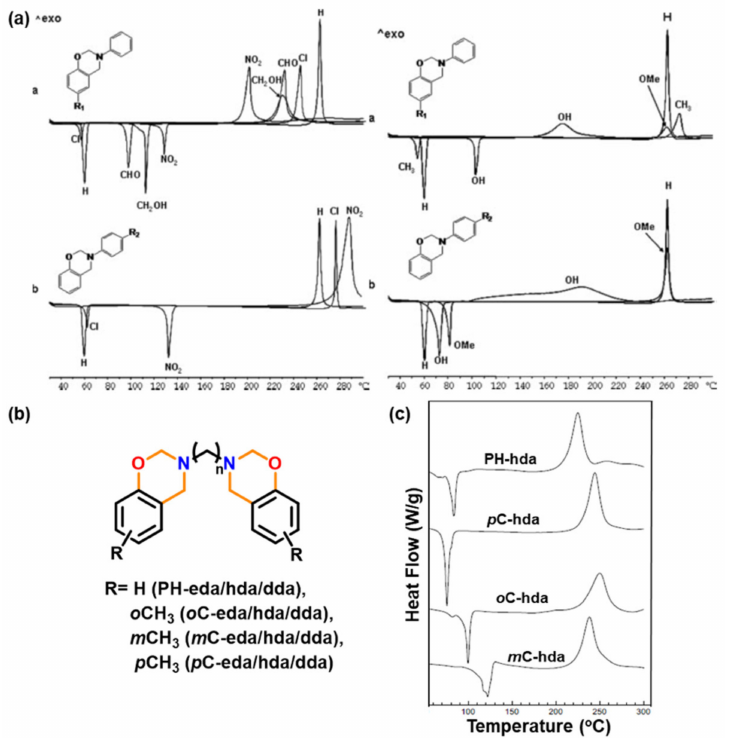
Figure 4. DSC thermograms of the ( a ) unsubstituted, para -, ortho - and meta -substituted mono- oxazine by varying substituents in phenol and aniline ring [138]. Copyright 2008. Reproduced with permission from Wiley Periodicals, Inc. ( b ) Bisbenzoxazine based on diaminohexane by varying methyl substituent in phenol ring ( o -, m - and p -cresol) and ( c ) non-isothermal DSC thermograms of the PH-hda, p C-hda, o C-hda and m C-hda monomers based on diaminohexane (hda) [137]. Copyright 2009. Reproduced with permission from Elsevier Ltd., Amsterdam, The